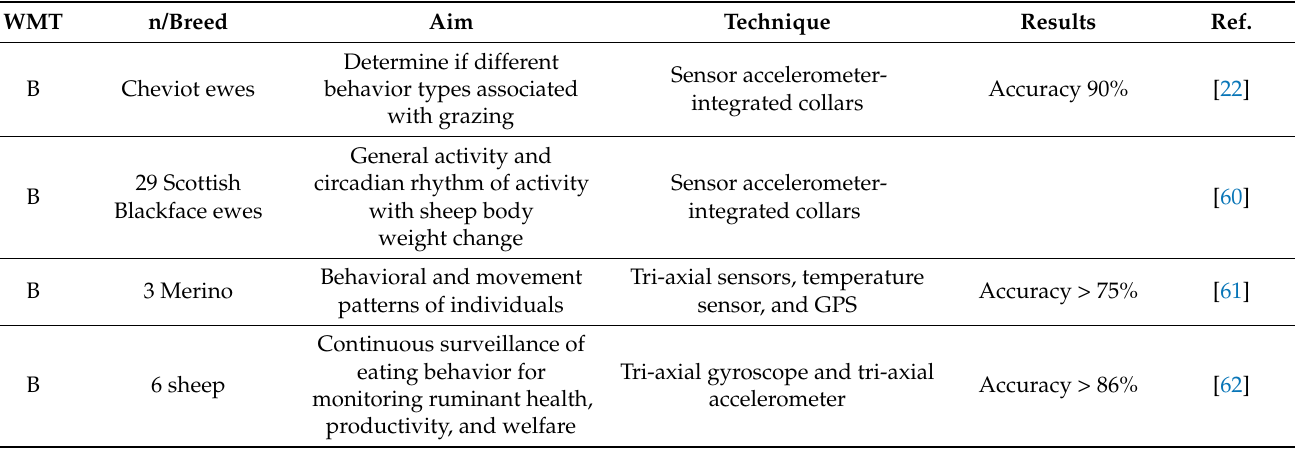
Table 1. Summary of research work to assess behavior, lambing time, lameness and live weight in sheep by kinematic and kinetic